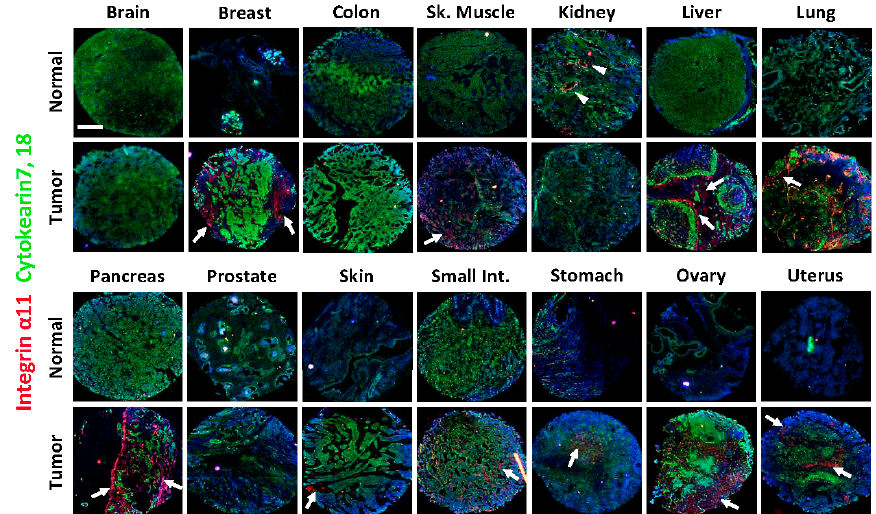
Figure 2. Expression of integrin α 11 in array sections from normal and tumor adult human tissues. Immunofluorescence staining was performed on the sections using α 11 203E3 mAb (red) and cytokeratin 7 and 18 (green). The cell nuclei were stained with DAPI (blue). In the normal tissues integrin α 11 expression was only detectable in the kidney section (arrowheads), while in the tumor tissues α 11 expression was detected in 10 of the 14 tumors tested (indicated by arrows in the respective tumor sections). Staining in each section was shown in a merged picture of two photos taken under a Zeiss Axioscope microscope (5×). Scale bar: 400 µm.